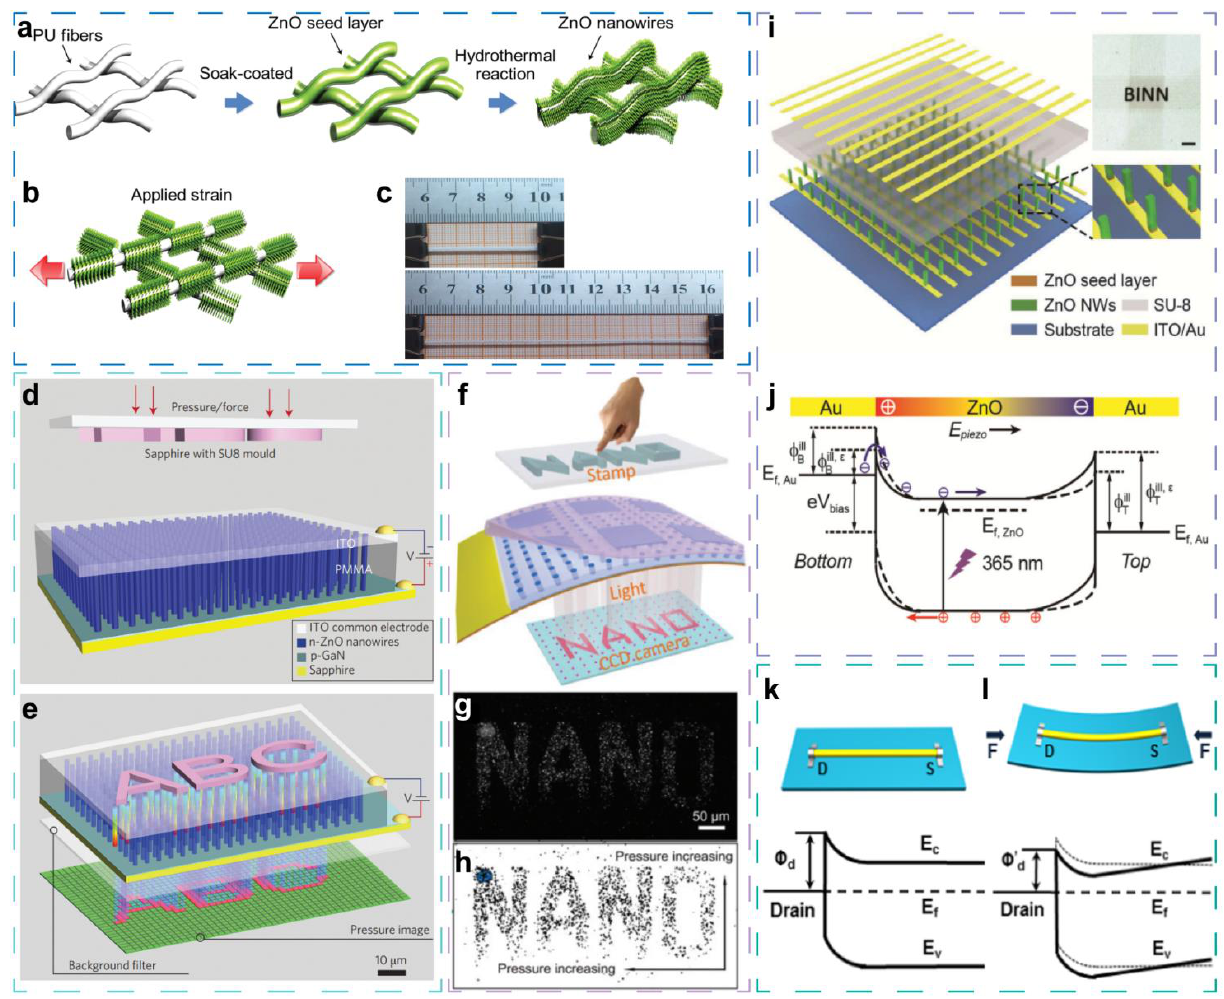
Figure 5. 1-D material-based environmental sensors with monolithically integrated strain/pressure detection. ( a ) Key fabrication steps for ZnO/PU fiber based sensor. ( b , c ) Schematic diagram and photograph of the ZnO/PU fiber-based sensor under tensile strain, respectively. Reproduced with permission. [56] Copyright 2015, Wiley-VCH. ( d , e ) Schematic diagram of device structure and experimental approaches of the LED array based on ZnO NWs for mapping pressure distribution, before ( d ) and after ( e ) applying a pressure by an “ABC” mold. Reproduced with permission. [34] Copyright 2013, Springer Nature. ( f ) Schematic illustration of the sensor based on CdS nanorods. ( g , h ) The light-emitting image and the two-dimensional contour map of the LED array under 100 MPa pressure from the “NANO” stamp, respectively. Reproduced with permission. [39] Copyright 2016, Royal Society of Chemistry. ( i ) Schematic structures illustration of the UV based on vertically aligned ZnO nanowires. Inset is an optical image of the device. The scale bar is 1 mm. ( j ) Energy band of Au/ZnO Schottky contact with compressive strains, illustrating working mechanism of the photodetector array. Reproduced with permission. [35] Copyright 2015, Wiley-VCH. ( k , l ) Energy band of the Schottky contact of ZnO gas sensor with and without compressive strains in vacuum, depicting the modulation on barrier height of piezotronic effect. Reproduced with permission. [36] Copyright 2015,